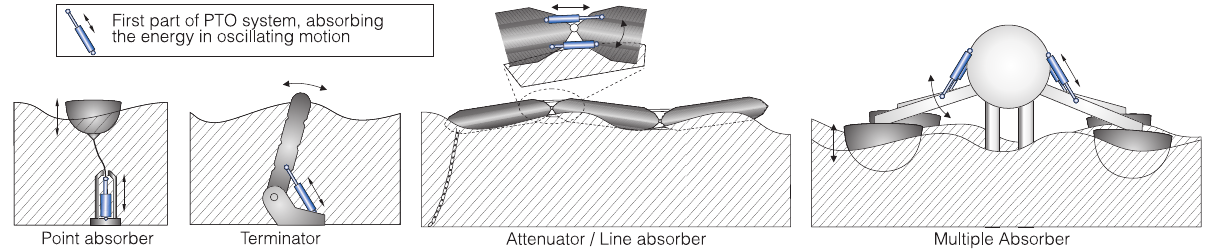
Figure 1. Different embodiments of Wave Energy Converters (WECs), capturing wave energy using buoyant oscillating bodies.